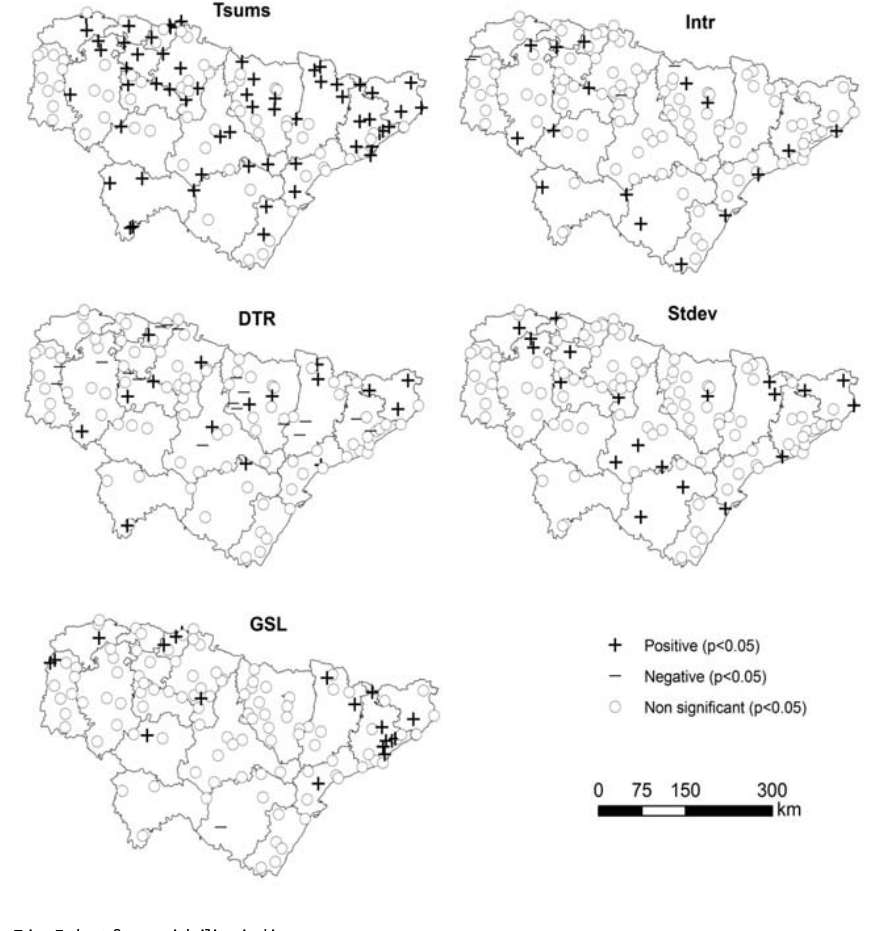
Figure 11. The same as Figure 5, but for variability indices. Fig. 11. The same as Fig. 5, but for variability